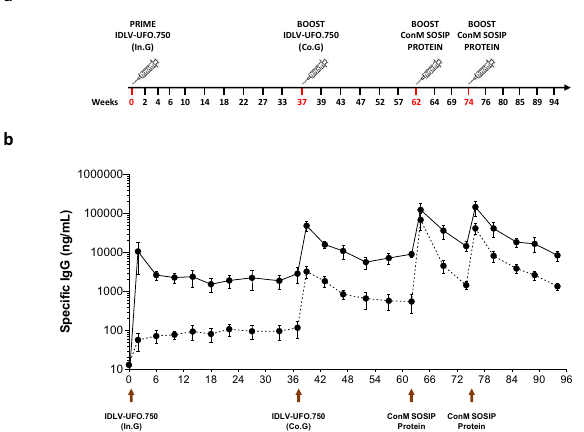
Fig. 7 Immune response in cynomolgus macaques after prime- boost vaccination with IDLV-UFO.750 and ConM SOSIP.v7 protein. a Schematic representation of schedule of immunization of fi ve cynomolgus macaques primed with IDLV-UFO.750 pseudotyped with VSV.G from Indiana serotype (In.G) and boosted at week 37 after the fi rst immunization with the same IDLV-UFO.750 but pseudotyped with VSV.G from Cocal serotype (Co.G). At 62 and 74 weeks after priming, monkeys were vaccinated with ConM SOSIP. v7 protein adjuvanted with MPLA. Serum and mucosal samples from vaccinated macaques were collected at the indicated time points (Weeks). b Time course of anti-Env IgG measured by capture ELISA in the sera of the immunized animals. Results are expressed as mean concentration (ng/ml) of speci fi c anti-ConSOSL.UFO (solid line) and anti-ConM (dotted line) IgG. Arrows indicate the immunization. Error bars indicate the standard error of the